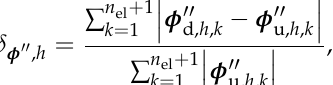
Figure 3. Modal parameters and relative difference between damaged and undamaged beams for different damage positions on the x-axis. ( a ) Thefirst three modes (displacement) φ for the undamaged beam. ( b ) Relative difference in natural frequencies δ f , h of the damaged beam compared to the undamaged beam. ( c ) Relative difference of the modes δ φ , h of the damaged beam compared to the undamaged beam. ( d ) Relative difference of the second derivative of the modes δ φ (cid:48)(cid:48) , h of the damaged beam compared to the undamaged